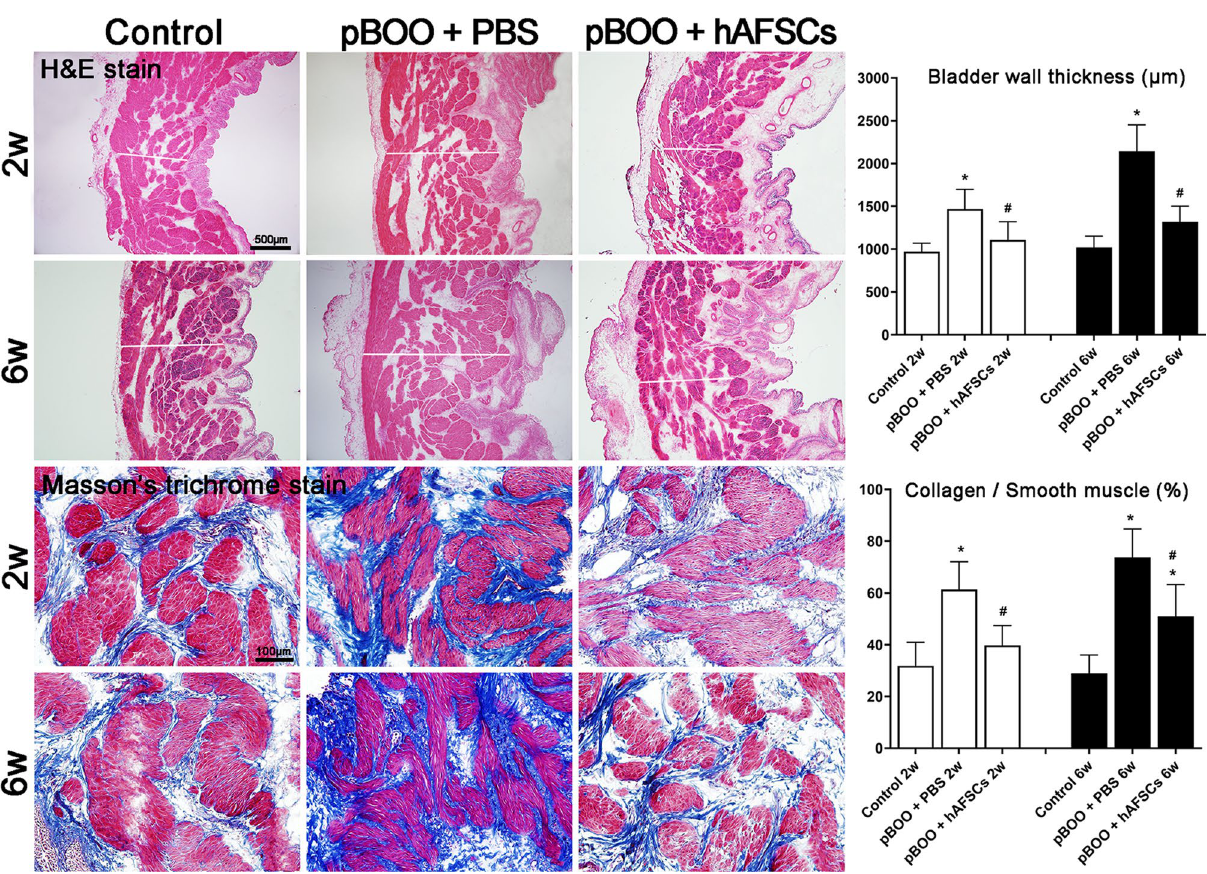
Figure 3. Hematoxylin–eosin and Masson’s trichrome staining of the bladder sections with quantitation of bladder wall thickness and ratio of collagen to smooth muscle. Bladder wall is thickened with detrusor muscle hypertrophy at 2 and 6 weeks after surgery in pBOO rats compared with control groups and the rats after hAFSCs treatment. Representative immunohistochemical staining shows the collagen with blue staining and the muscle with red staining. The collagen deposition increases in the pBOO group and recovers after hAFSCs treatment. *: P < 0.05 vs. control, #: P < 0.05 vs. pBOO + PBS. N = 6 in each time point. Bar indicates 500 μm in Hematoxylin–eosin staining and 100 μm in Masson’s Trichrome staining, respectively. The bladder wall thickness was measured at the 4 ends of a cross in 3 whole bladder sections separated in 1 mm for each rat. The horizontal white line in each panel of Hematoxylin–eosin staining indicates the location of measuring bladder wall